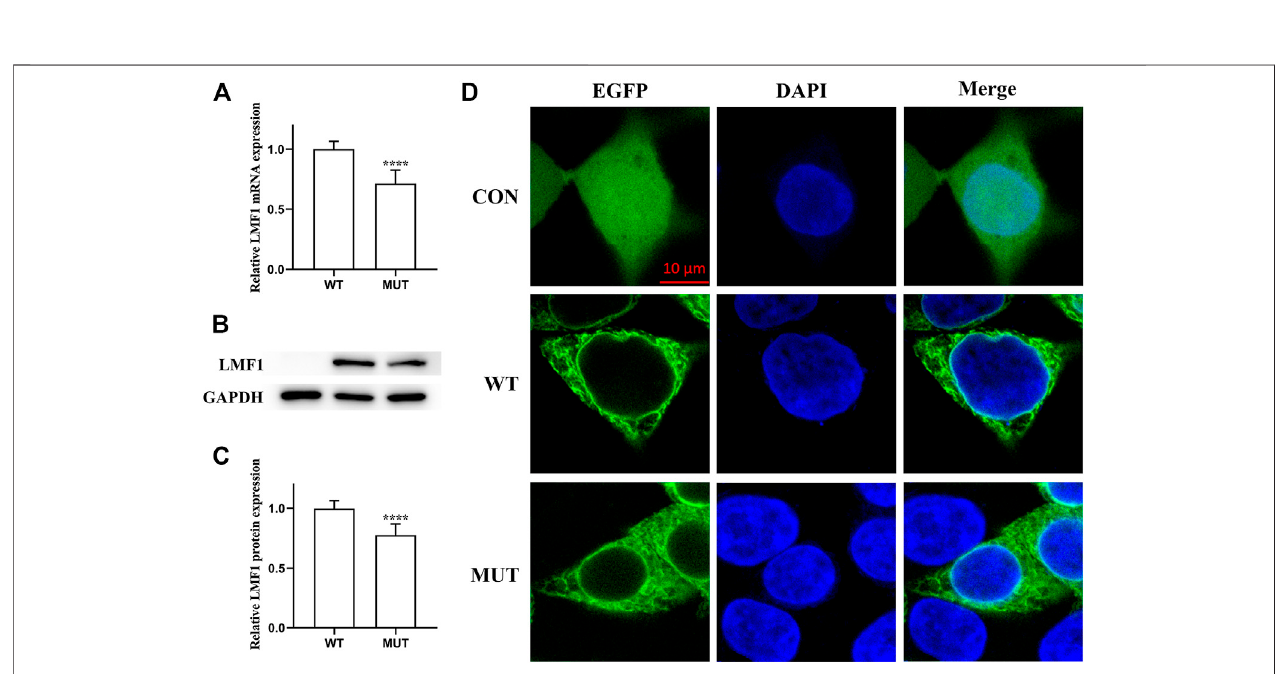
FIGURE 3 | Functional analysis of the LMF1 mutant protein. (A) . mRNA expression levels of wild-type and mutant LMF1 genes in HEK293T cells. There was a signi fi cantdifferenceinthemRNAlevelofthewild-typeandthemutantgenes(**** p < 0.0001). (B) .WesternblottingofLMF1expression. (C) .Proteinexpressionlevelsof wild-type and mutant LMF1 genes in HEK293T cells. The mutant LMF1 protein expression was lower than that of the wild-type proteins in HEK293T cells (**** p < 0.0001). (D) . Subcellular localization of wild-type and mutant LMF1 in HEK293T cells.